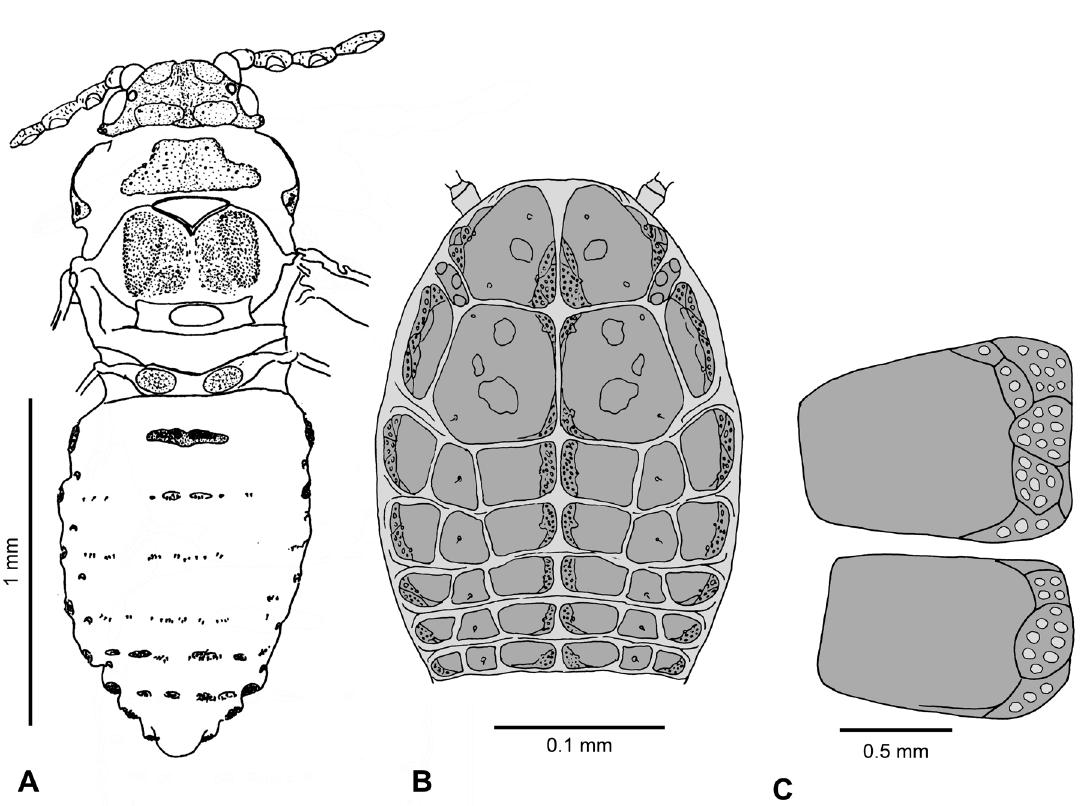
Fig. 46. Adelges (Dreyfusia) nordmannianae (Eckstein, 1890). A . Gallicola (after Carter 1971, redrawn from Heie 2004). B–C . Hibernating first instar nymph (neosistens). B . Habitus, showing arrangement of sclerites plates and wax gland pits (after Schneider-Orelli 1947, modified and redrawn from Börner & Heinze 1957). C . Spinal sclerites of meso- and metathorax, left side (after Pschorn-Walcher & Zwölfer 1958, modified and redrawn).